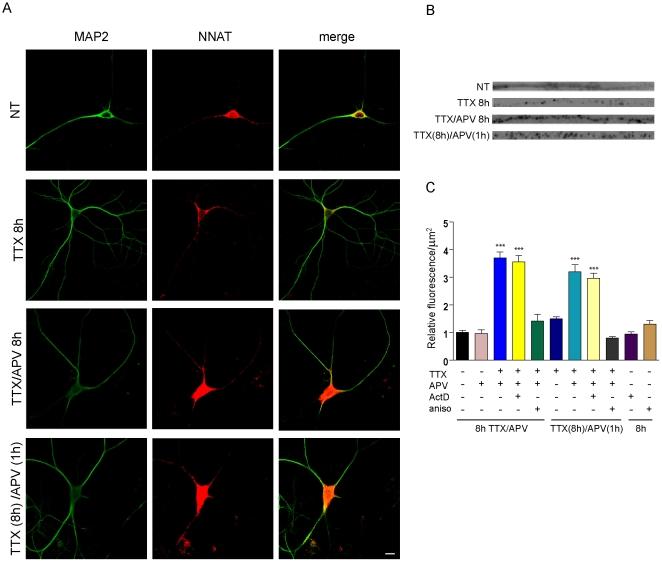
Neuronatin is dendritically translated in response to TTX/APV.(A) Cultured hippocampal neurons were immunostained for MAP2 and NNAT after no treatment, or treatment with 8 h TTX, 8 h TTX/APV, or TTX (8 h)+APV(1 h). Scale bar: 10 µm. (B) Magnified 30 µm straightened dendritic segments taken from neurons treated as in (A) showing NNAT distribution. Images were grayscaled to enhance contrast. (C) Quantification showing NNAT fluorescence in response to TTX/APV as a function of dendritic area (in µm2). All values were compared to no treatment (NT). Sample size: NT, n = 39; 8 h APV, n = 14; 8 h TTX/APV, n = 30; ActD+8 h TTX/APV, n = 30; aniso+TTX/APV, n = 12; 8 h TTX alone, n = 38; TTX (8 h)+APV (1 h), n = 18, TTX (8 h)+APV(1 h) ActD, n = 22; TTX (8 h)+APV(1 h) aniso, n = 27, actinomycin D (ActD), n = 20, anisomycin (aniso), n = 12. *** p<0.001). Each condition was performed using at least 3 independent batches of cultures.